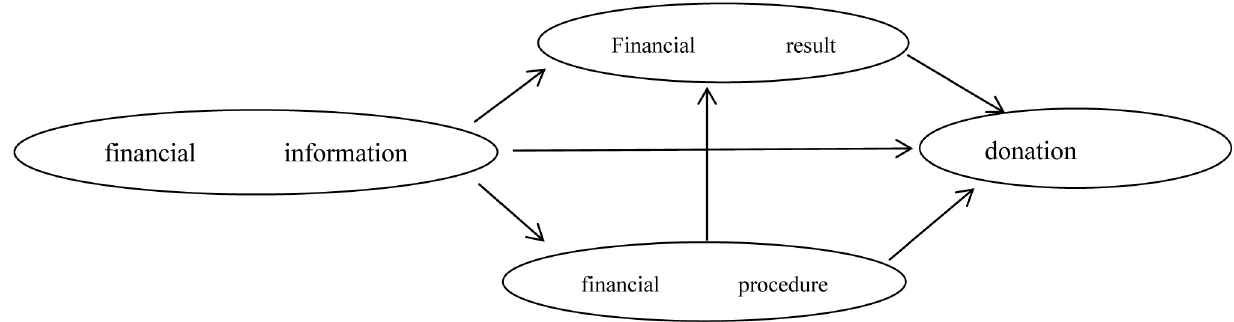
Fig 5. Models for financial fairness perception and donation intention of individual donors in